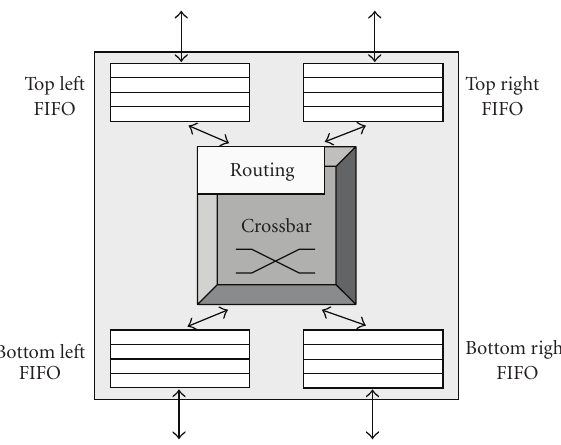
Figure 7: View of the DRAFT unitary router